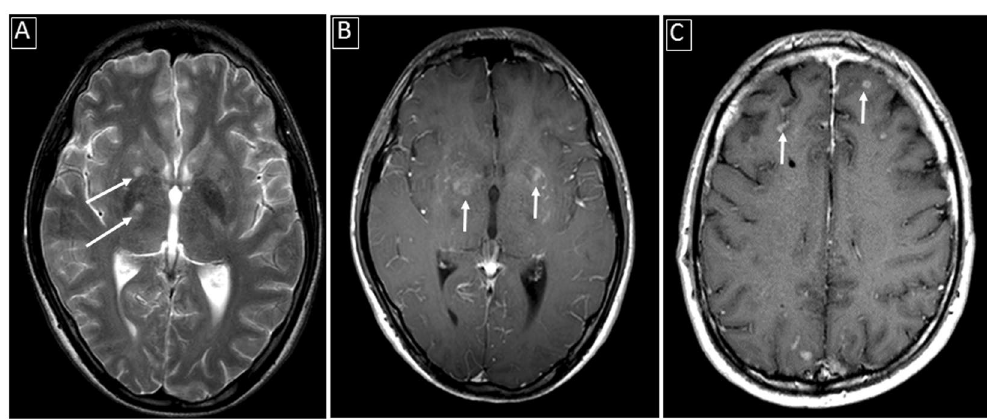
Figure 1. Examples of parenchymal involvement in CNS cryptococcosis: ( A ) Abnormally enlarged perivascular spaces in the basal ganglia bilaterally (white arrows) on T2-weighted image; ( B ) Abnormal enhancing lesions in the basal ganglia (white arrows) in the same patient as A on enhanced T1-weighted image; ( C ) Superficial focal parenchymal enhancing lesions (white arrows) adjacent to sulcal meningeal